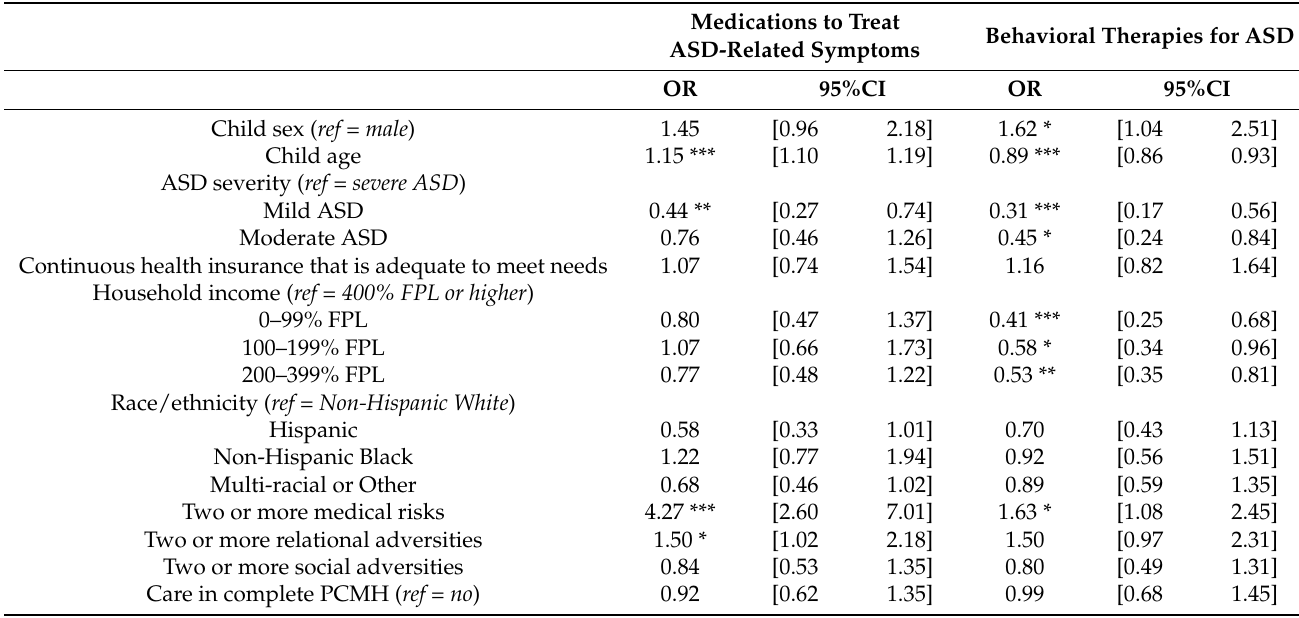
Behavioral Therapies for